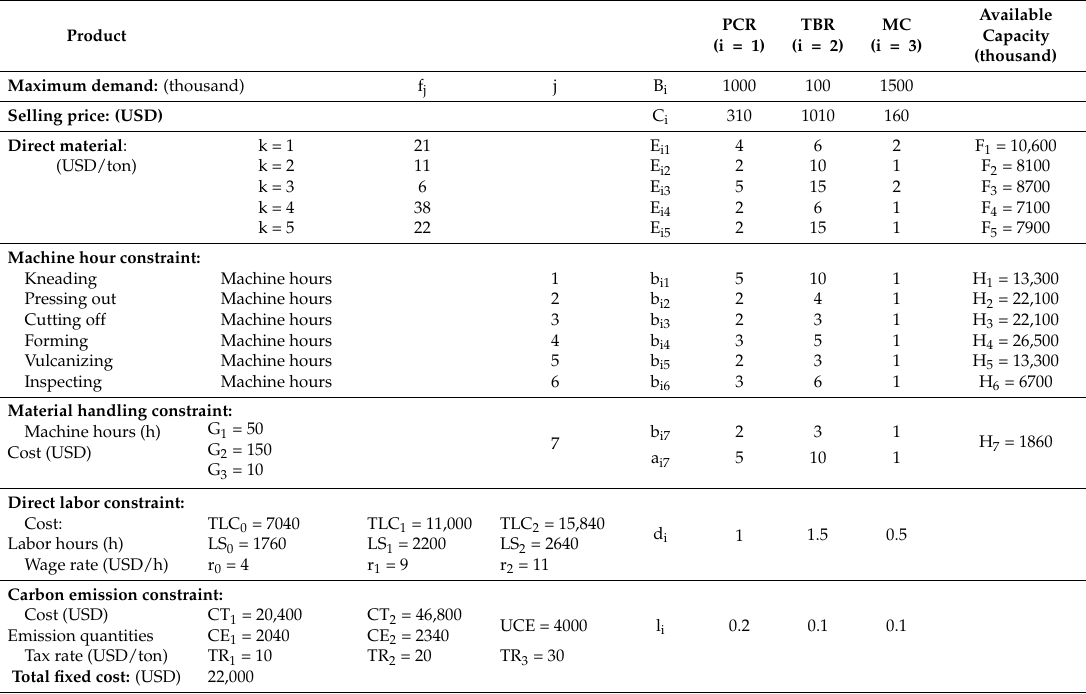
Table 1. Data for illustrative example (Company